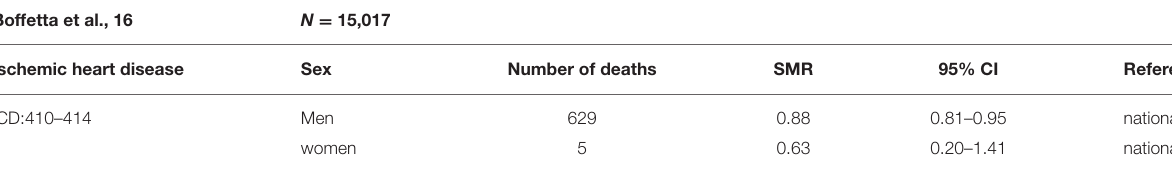
TABLE 8 | European cohort study on TiO 2 . Boffetta et al.,